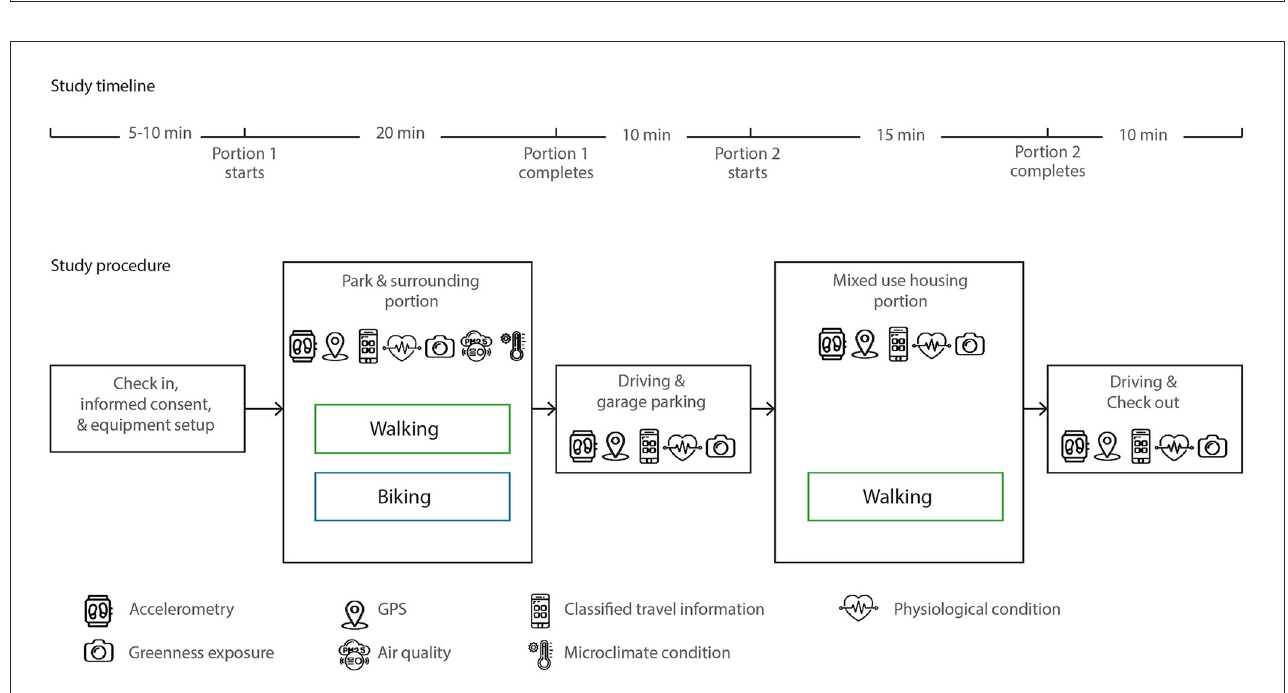
FIGURE2 Predefined study route and mode of travel.